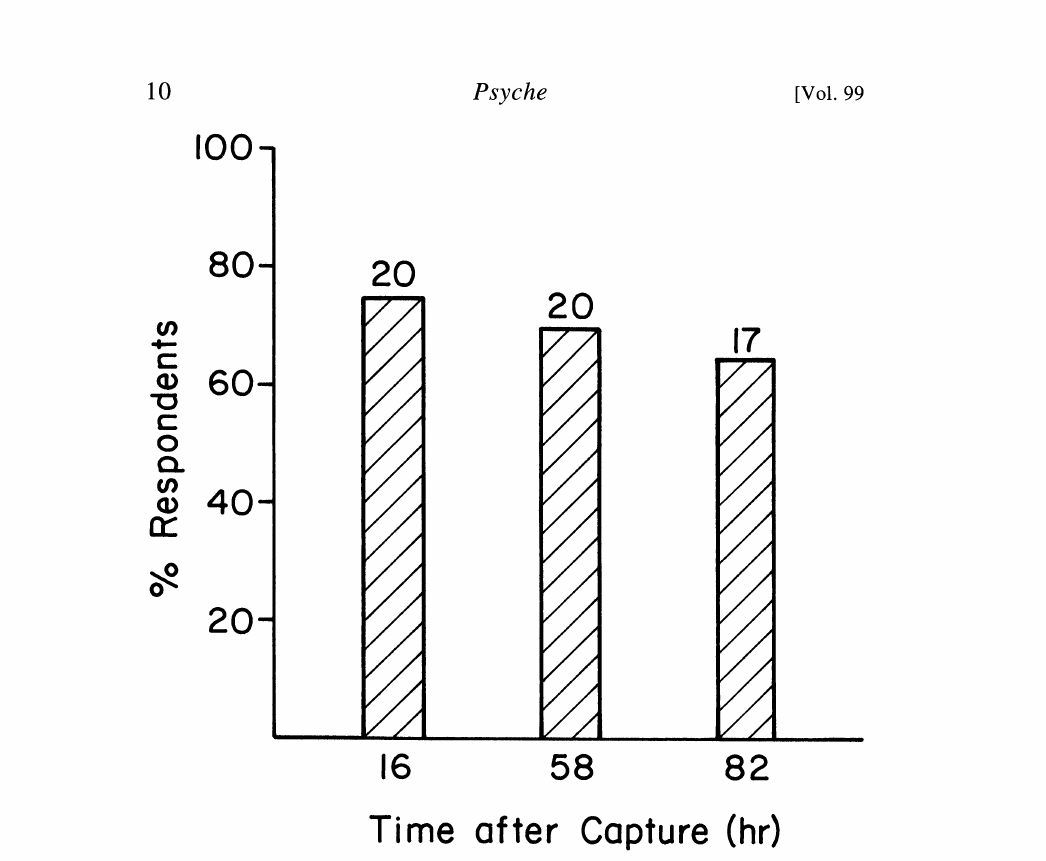
Fig 4. Incidence of spraying in 20 E. auxiliaris, plotted as a function of time after capture. The moths were stimulated at the times shown, by pinching an indi- vidual leg with forceps. Between stimulations the moths were given access to water only. The reduced sample size at 82 hr reflects loss of 3 individuals to